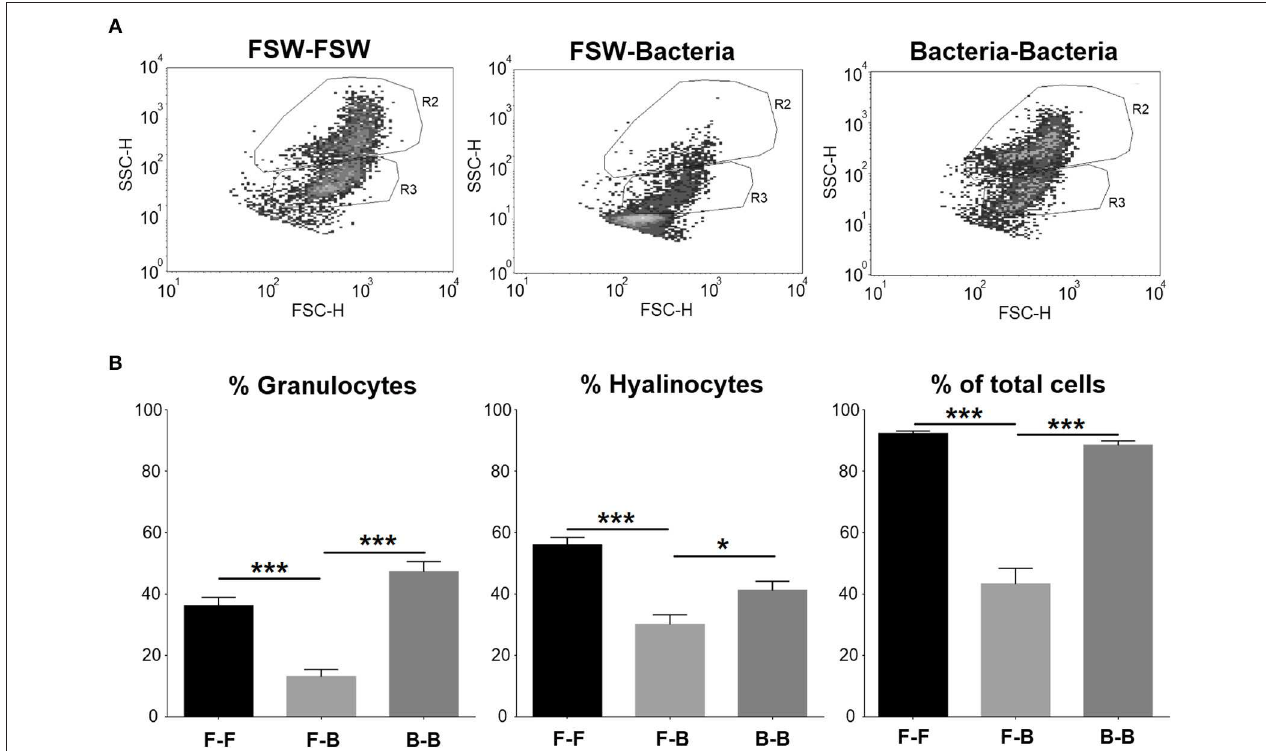
FIGURE 5 | FACS analysis of the cell population distribution of mussel hemocytes after subsequent FSW/bacteria injection. (A) Dot plot of a total count of 100,000 events for hemolymph. R2, granulocytes; R3, hyalinocytes. (B) Statistical analysis of the hemocyte population in the different experimental conditions. Asterisks show the statistical significance: * p < 0.05 and *** p < 0.0001. Subsequent stimulations are indicated as follows: F-F, FSW and FSW; F-B, FSW and bacteria; B-B, bacteria and